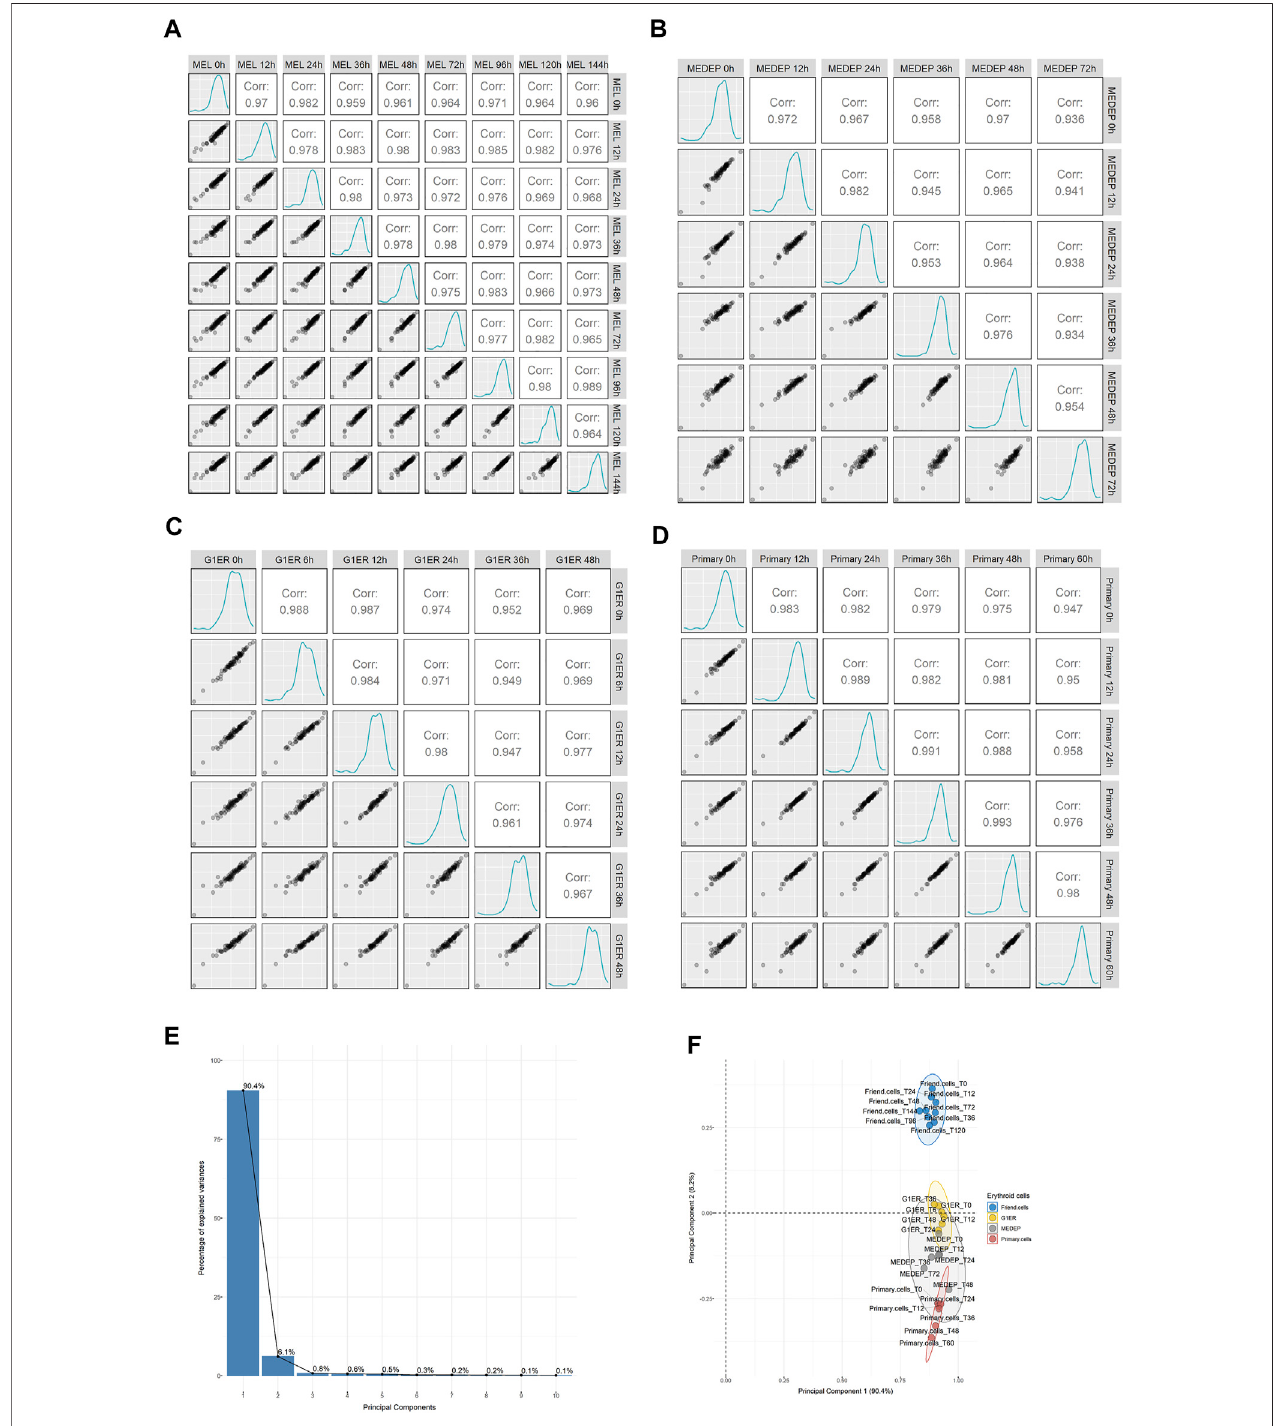
FIGURE4| Regulationofribosomalproteinsonawholecelllevelinproteomicsdataoutof4modelsofmurineerythroiddifferentiation(retrievedfromGautieretal.). ScatterplotsdepictingtherelationshipofaveragenormalizedintensityvaluesofRPsacrossallstagesofdifferentiationin: (A) MEL, (B) MEDEP, (C) G1ERand (D) primary cells. (E,F) Principal component analysis (PCA) using normalized intensity values of RPs for all independent samples from the study of Gautier et al. The scree plot of Panel E depicts the percentage of variance explained by each principal component (PC), and the scatterplot of Panel F shows the distribution of samples in the spaceofPC1andPC2.Notably,variationismainlyexplainedbyPC1andPC2whiletheindependentsamplesformdistinctclustersbasedonthecelltyperatherthanthe differentiation stage, thus supporting invariable ribosomal protein stoichiometry during erythroid differentiation.